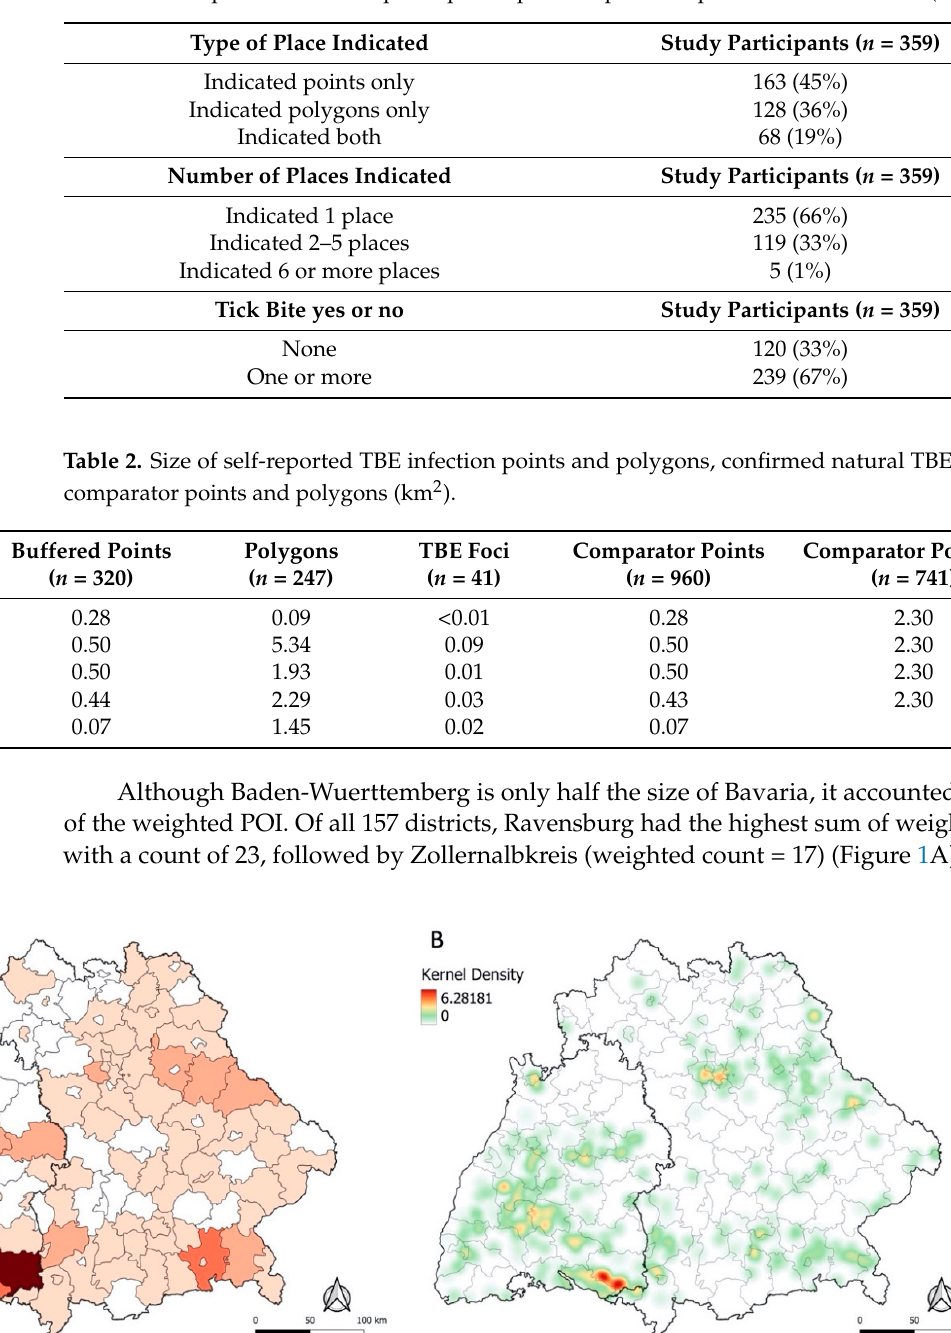
Table 1. Descriptive statistics of participant reports on probable places of TBE infection (POI).